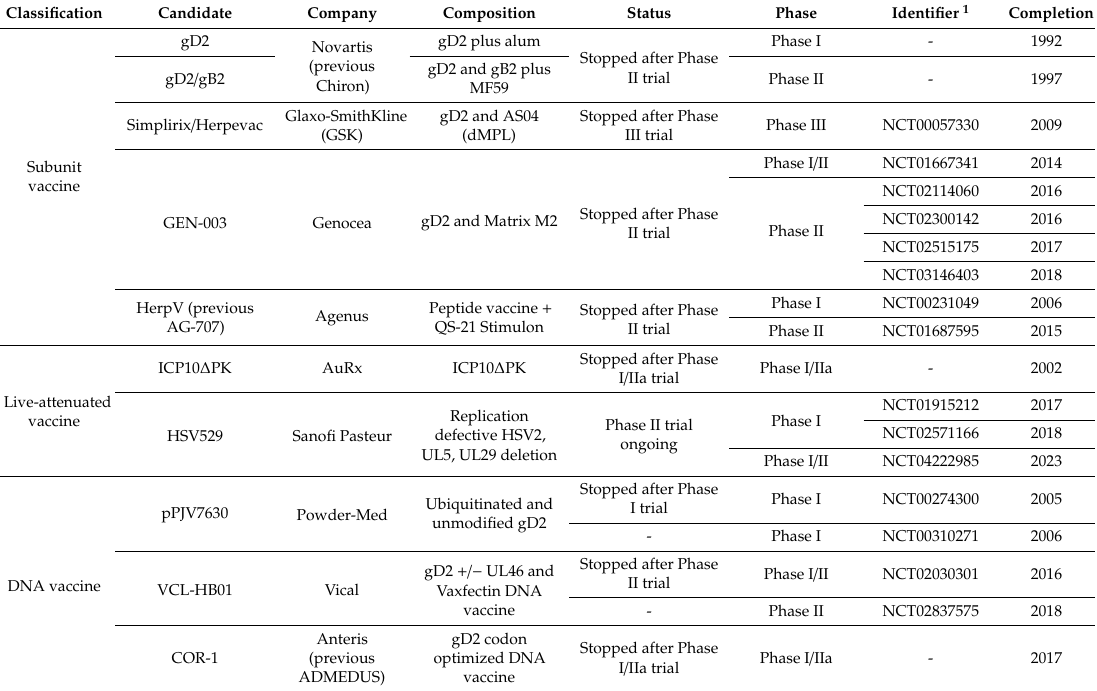
Table 1. Genital herpes vaccine clinical trial status